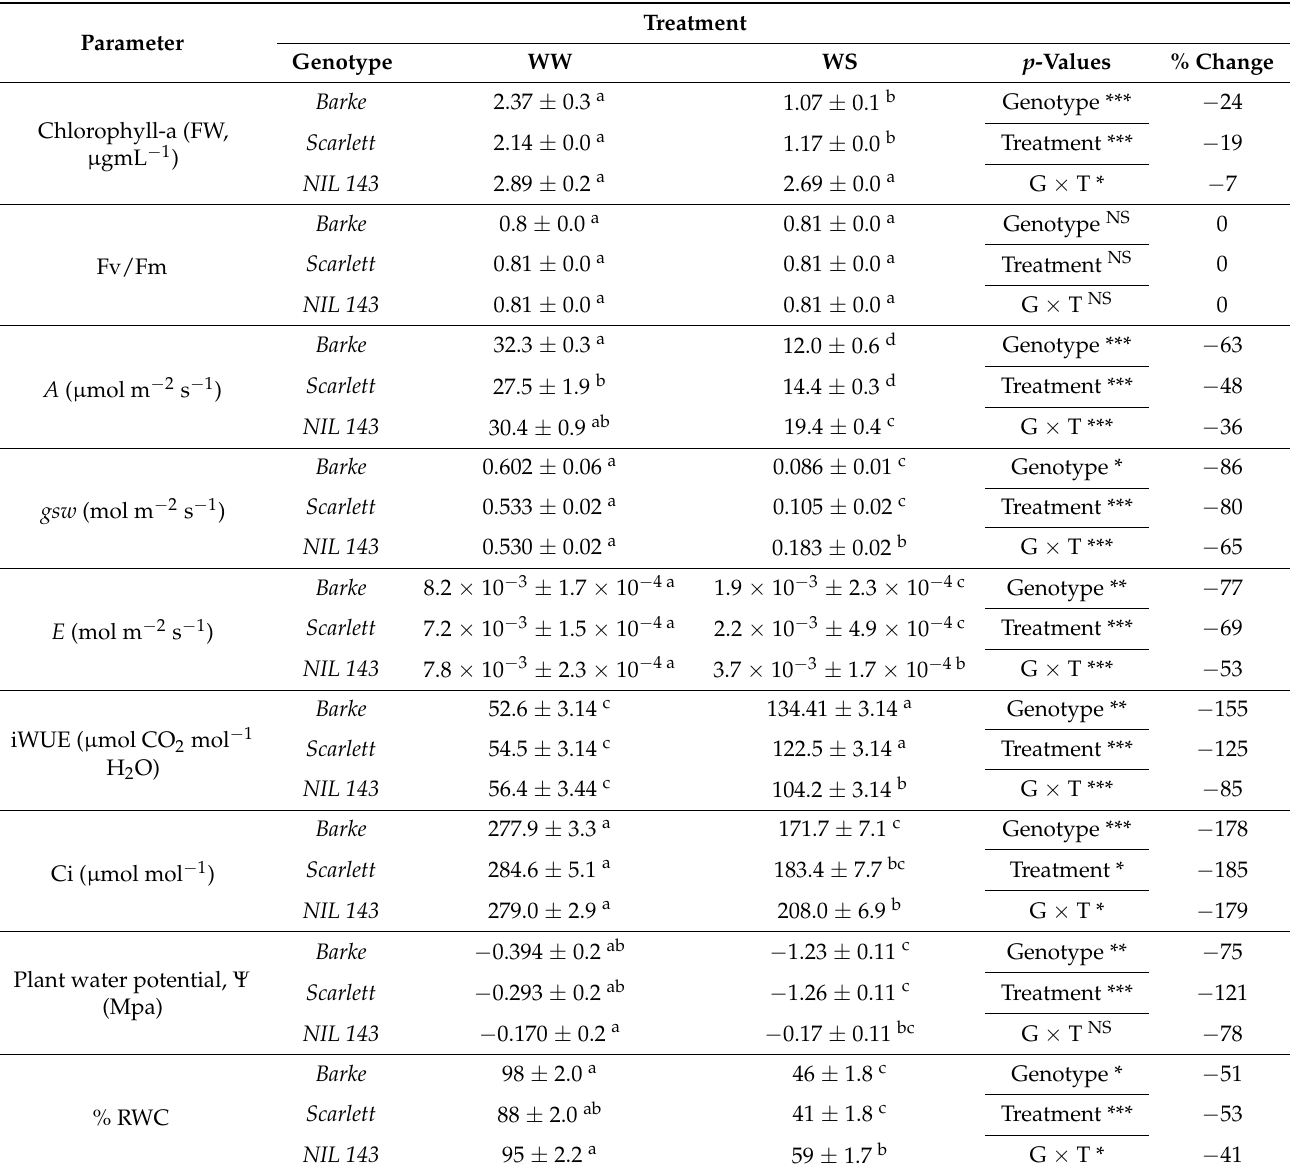
Table 2. Physiological plant traits of different barley genotypes 17 days after the onset of water stress in the rhizoboxes